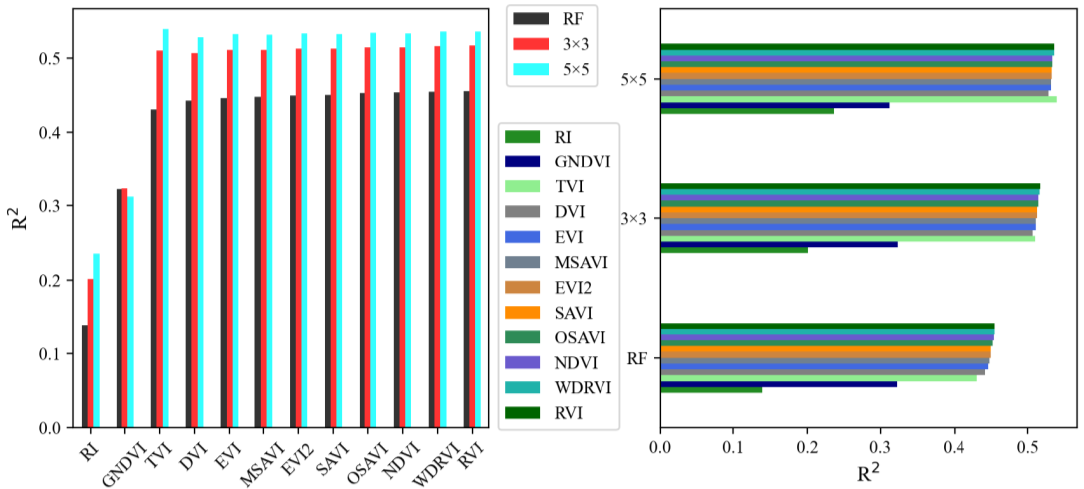
Figure 5. Model determination coefficient (R2) of GF-1 data.